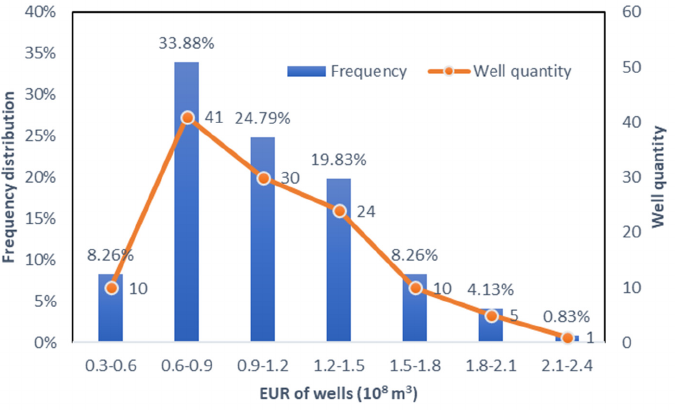
Figure 1. Structural map of the Weiyuan shale gas field.